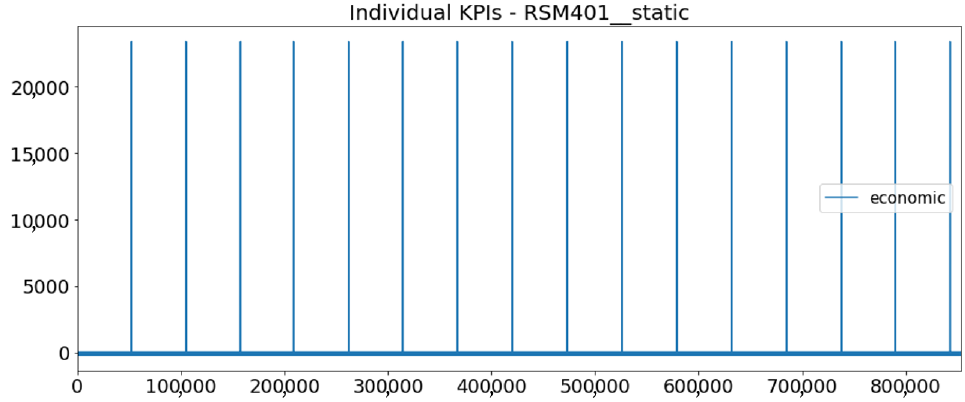
Figure 8. KPI time series for the static component yielded from running the model for the friction welding machine (HWH). The simulation interval has the same length as for training (292